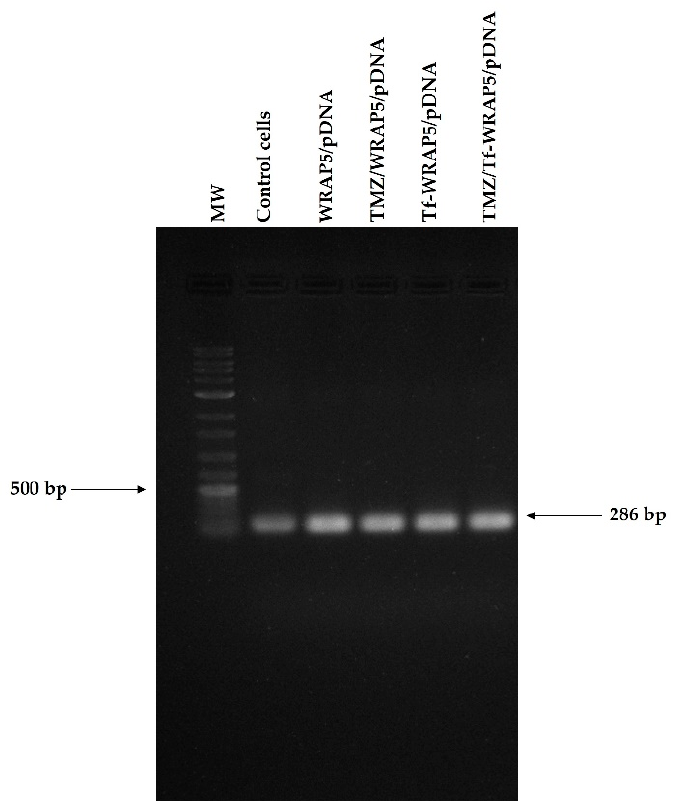
Figure 6. PCR analysis of p53 mRNA in U-87 cells after 24 h of transfection mediated by the developed complexes formed at an N/P ratio of 1. MW-DNA ladder molecular weight marker.